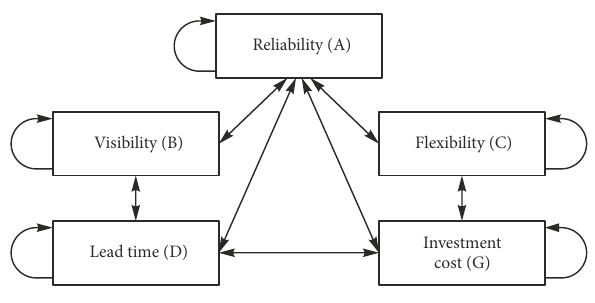
Lead time (D) Investment cost Figure 5. Relationship between dimensions preferred by shippers